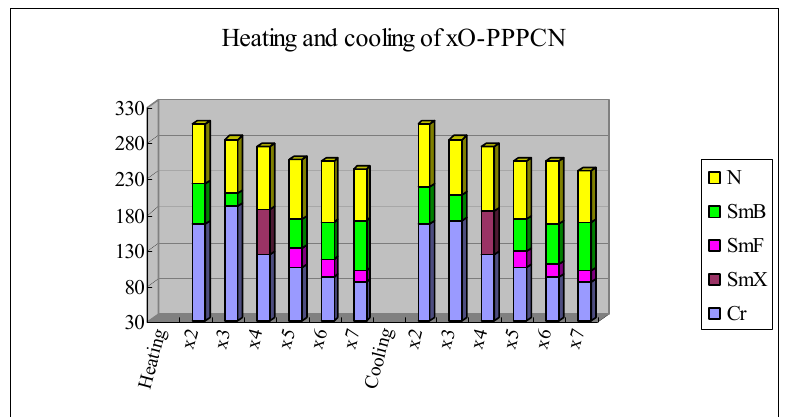
Figure 4. Plot of transition temperatures of heating and cooling cycle for compounds of 4-alkoxy-4'-cyano- p -terphenyls ( xO- PPPCN, x =